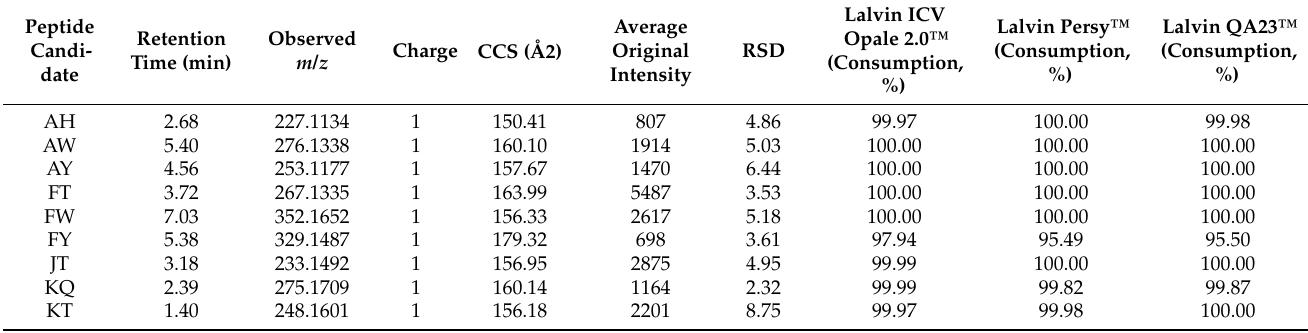
Table A4. The proposed dipeptide sequences and observed relative consumption during fermentation with Lalvin ICV Opale 2.0™, Lalvin Persy™ and Lalvin QA23™ of the modified synthetic must. Peptide sequences were acquired by peptide mapping to bovine serum albumin protein sequence (UniProtKB–P02769 (ALBU_BOVIN)). Additionally presented are the retention time, observed m/z , collision cross section values, as well as the averaged peptide intensities at the starting point and associated relative standard